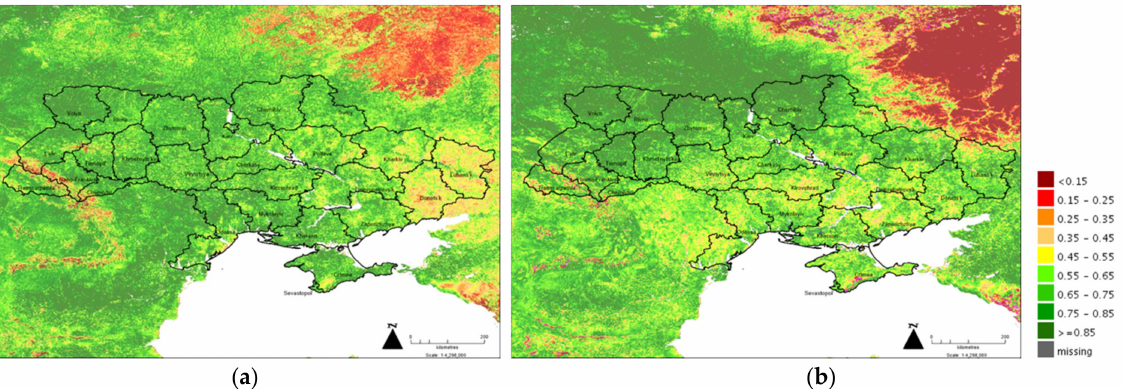
Figure 2. The VCI for March 2021 ( a ) and March 2022 ( b ). The scale for the VCI is shown to demonstrate differences between VCI for each planting season in the Ukrainian Oblasts